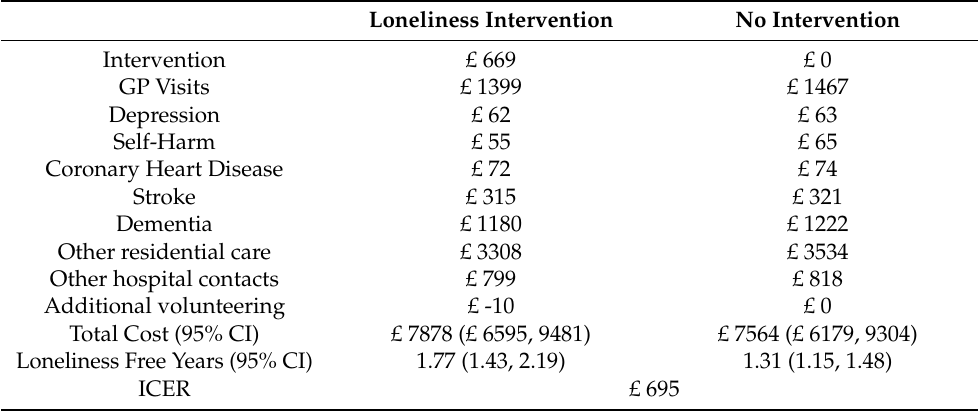
Table 3. Summary of cost-effectiveness findings (broader perspective including informal care costs for stroke and